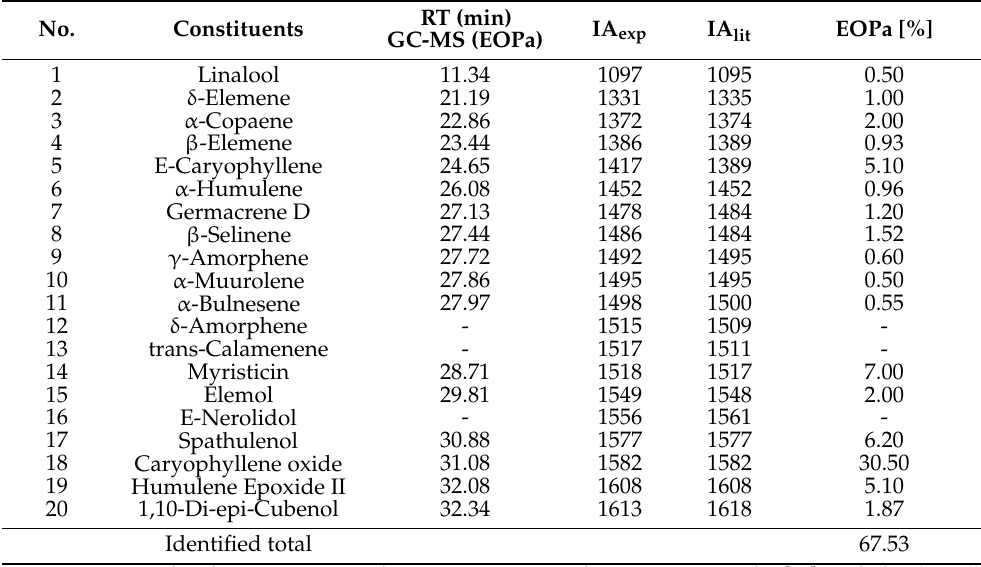
Table 1. Chemical composition of the essential oil of Piper arboreum (EOPa).